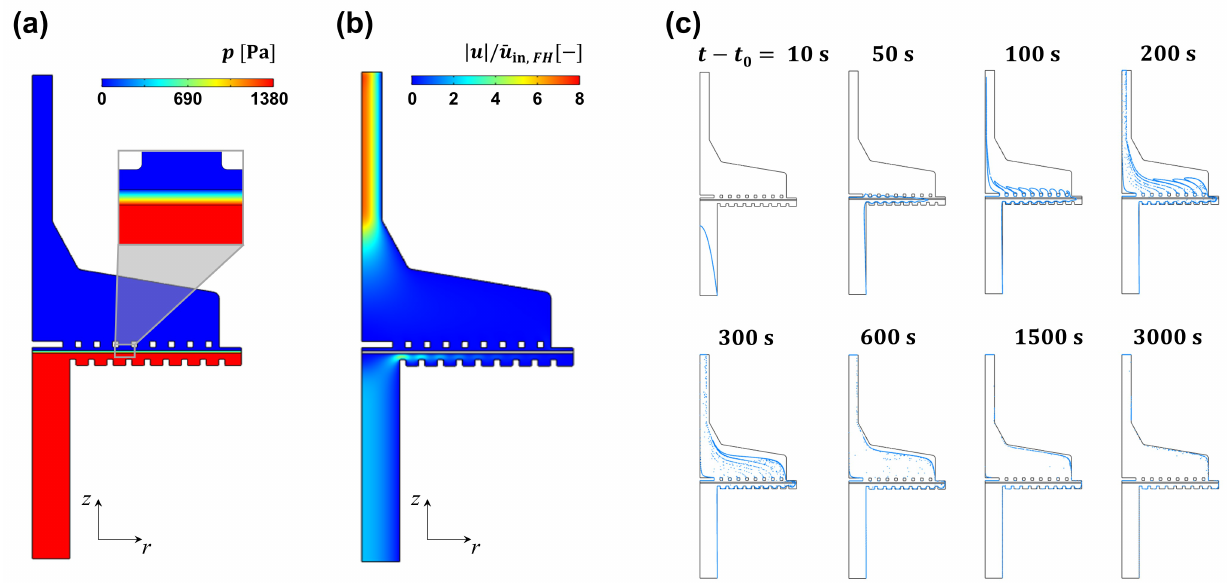
Figure 8. ( a ) Pressure field within the filter holder, ( b ) velocity magnitude in the filter holder, and ( c ) trajectory of passive tracers under the flow that develops within the filter holder, where t 0 is the time when the completely mixed stream of the feed solution reaches the inlet port of the filter